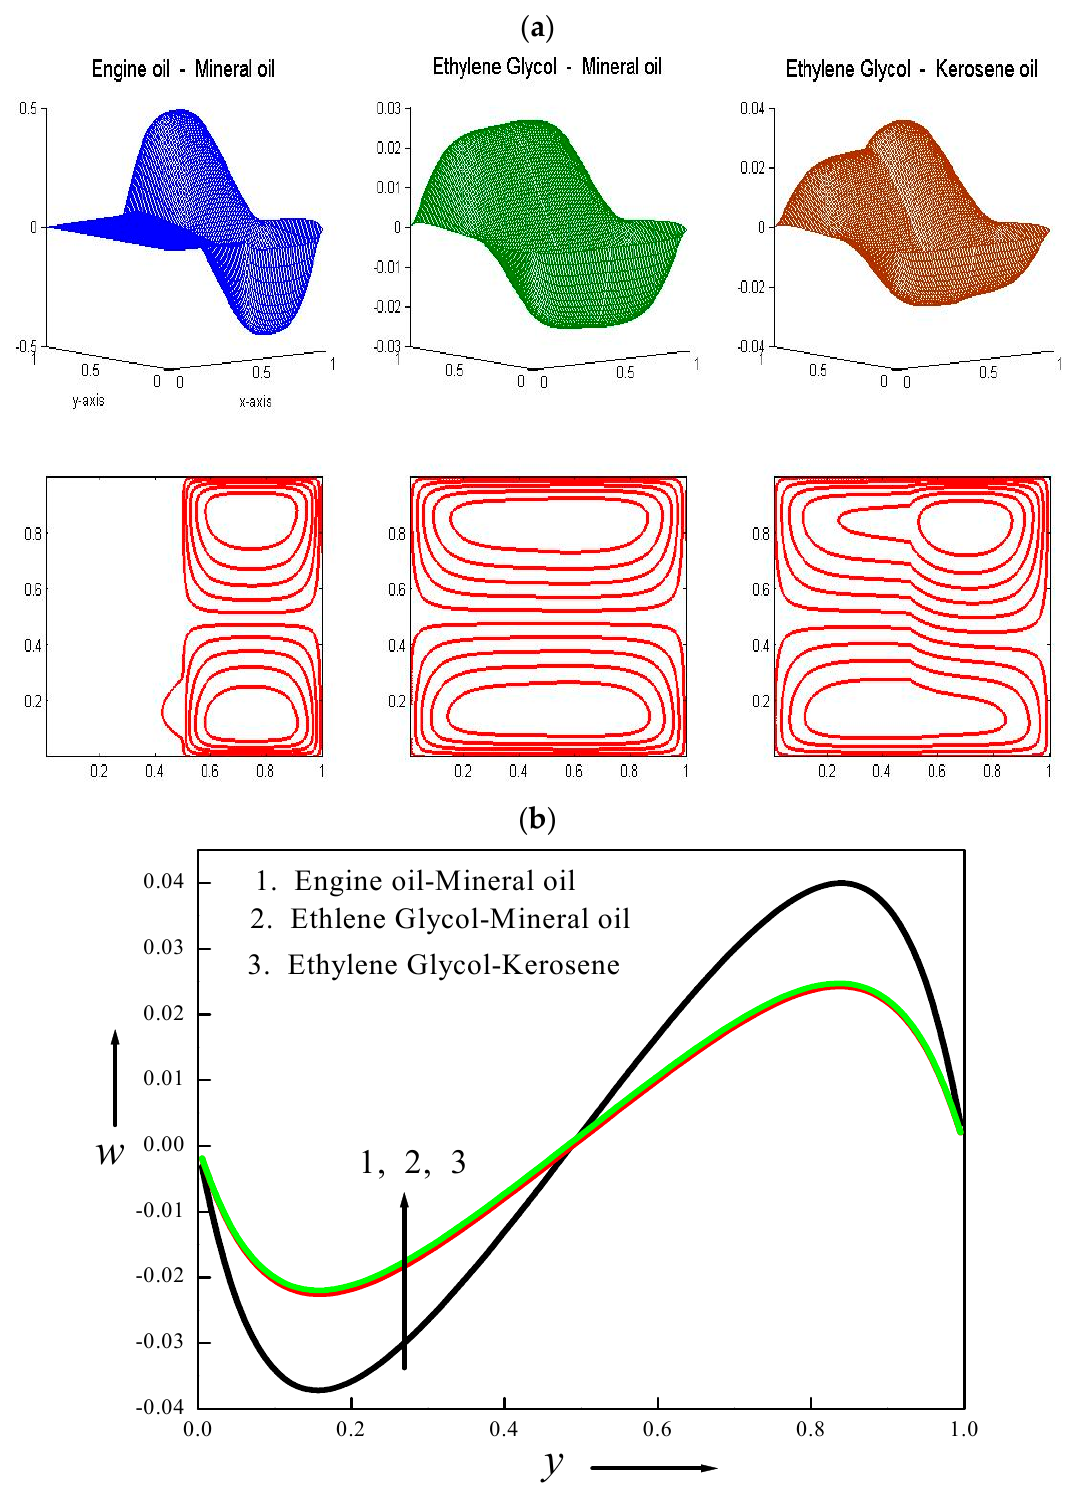
Figure 2. Velocity ( a ) contours and ( b ) profiles for altered base fluids.